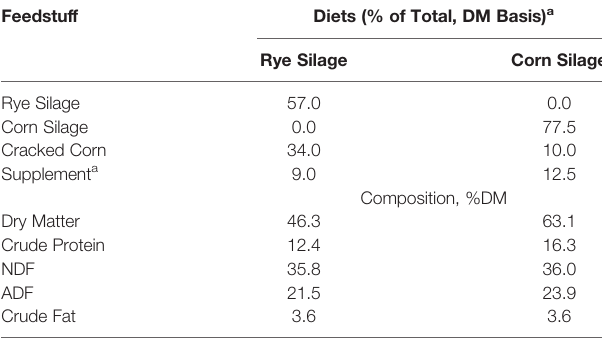
TABLE 1 | Composition of diets fed to donor steers. Feedstuff Diets (% of Total, DM Basis) a Rye Silage Corn Silage Rye